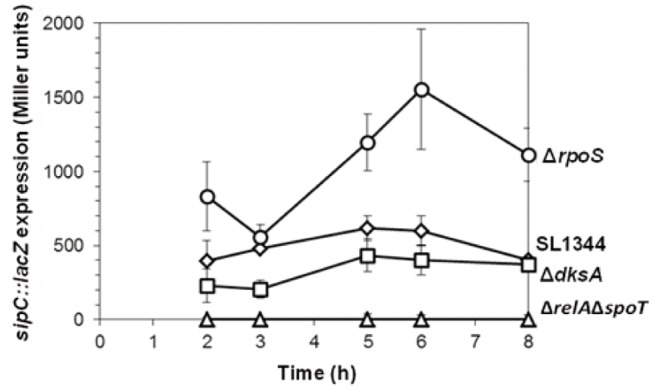
Expression of an S. Typhimurium sipC::lacZ fusion in parental, ΔrelAΔspoT (ppGpp0), ΔdksA and ΔrpoS backgrounds during growth in aerobic LB batch cultures.Data is from 3 biological replicate experiments.